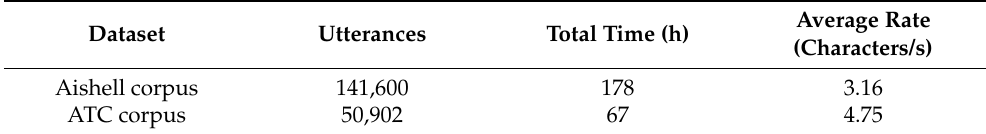
Table 1. Basic information of the datasets.